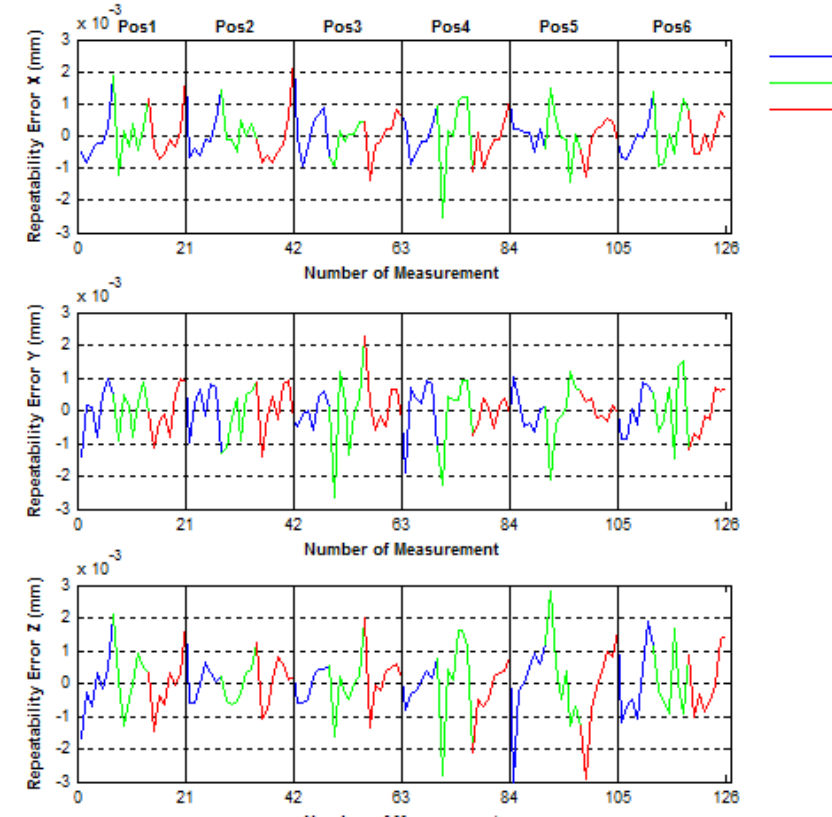
Figure 19. Positioning mechanical repeatability errors of the platform for the Continuous